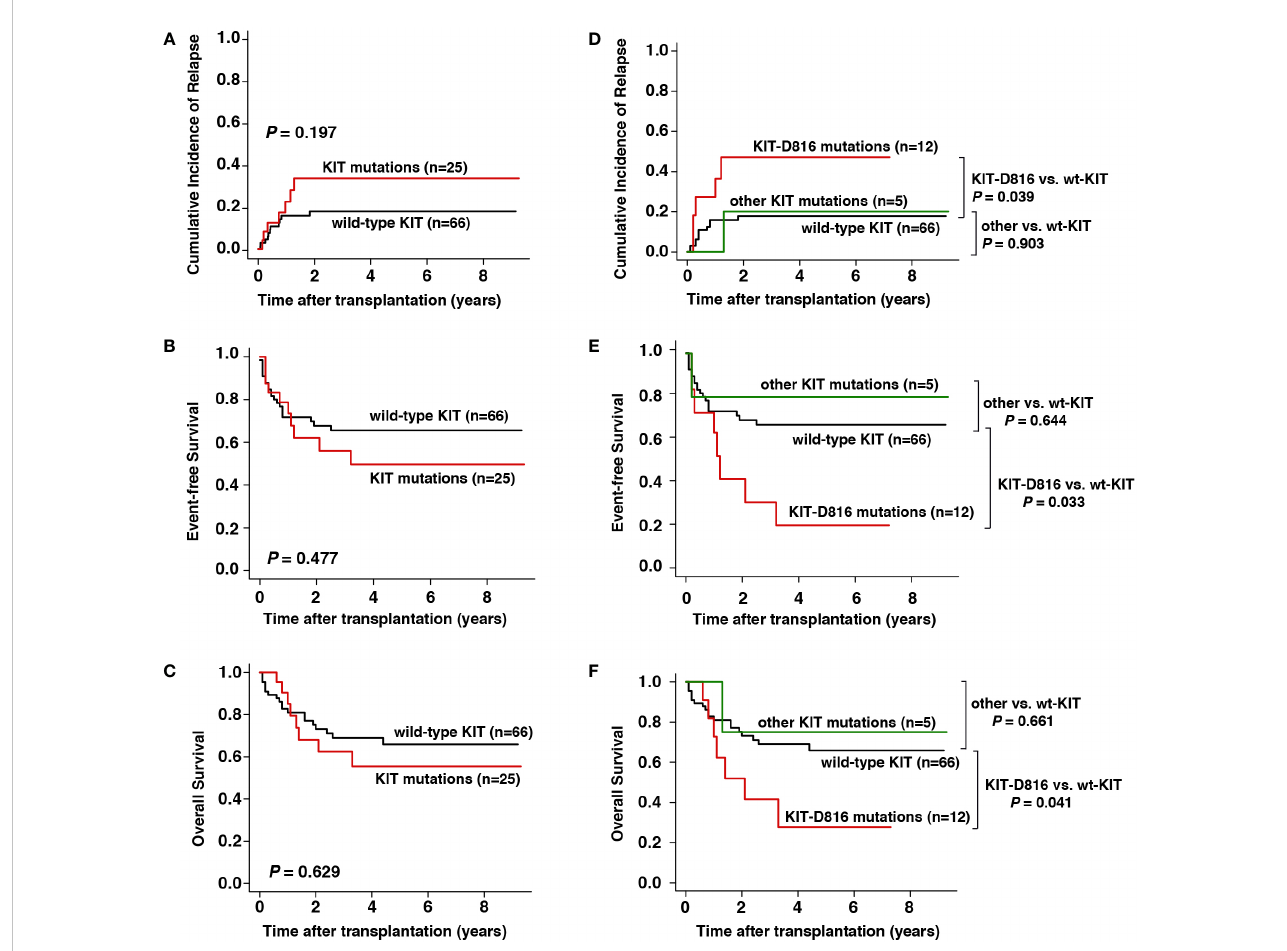
FIGURE 4 Prognostic impact of KIT mutation at diagnosis on outcomes. (A – C) CIR, EFS, and OS between patients with and without KIT mutation, (D – F) CIR, EFS, and OS between patients with KIT -D816 mutation, other KIT mutation, and without KIT